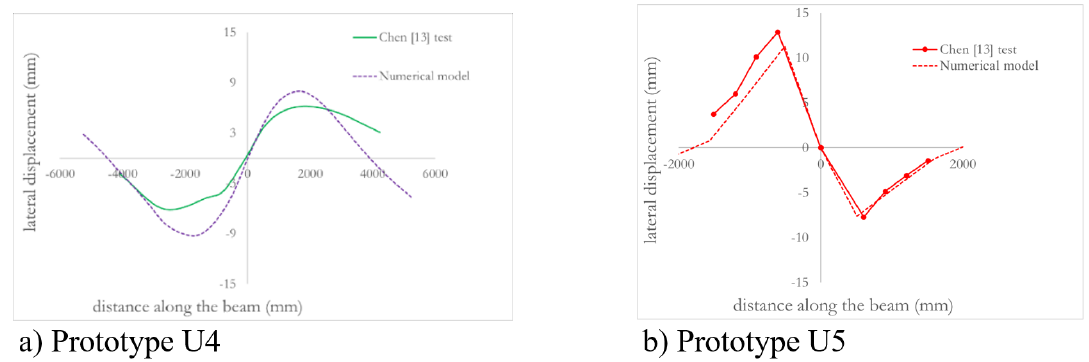
Figure 9. Lateral displacement of the bottom flange of the steel